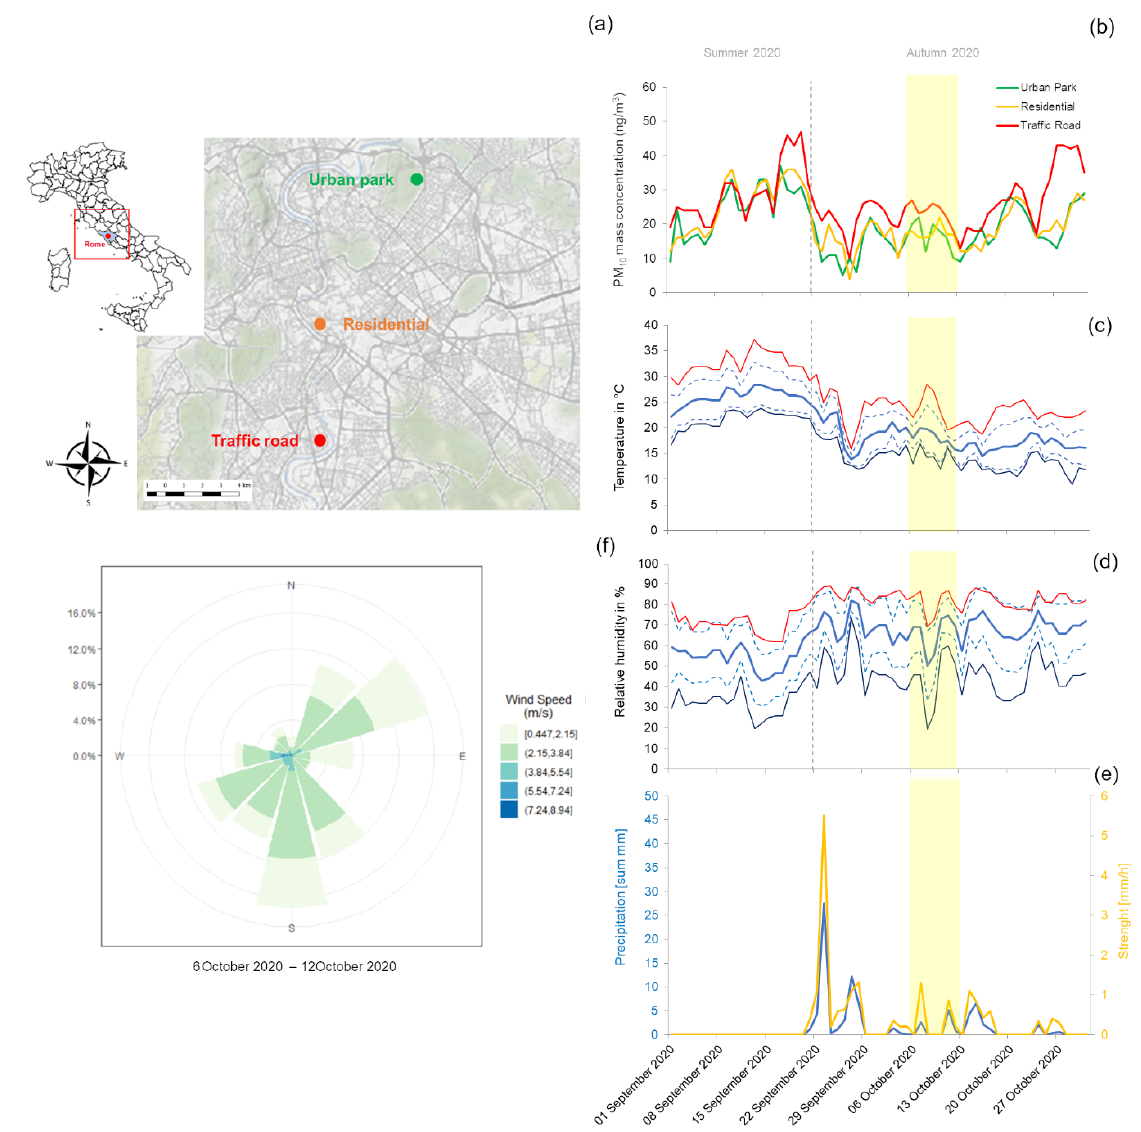
Figure 1. Overview of the three urban sites (Urban Park, Residential and Road Traffic) of Rome ( a ), PM 10 mass concentration ( b ), three meteorological parameters (temperature, relative humidity and precipitation) ( c – e ) and wind conditions (speed and direction) ( f ), recorded during the sampling campaign of Early Autumn 2020 (yellow shaded area). For temperature and relative humidity, the solid lines represent the daily-averages (blue), the maxima (red) and the minima (dark blue). The standard deviations are reported as dashes lines.